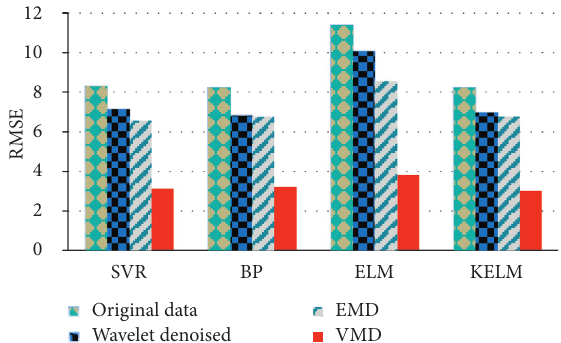
Figure 9: RMSE comparison of different approaches.